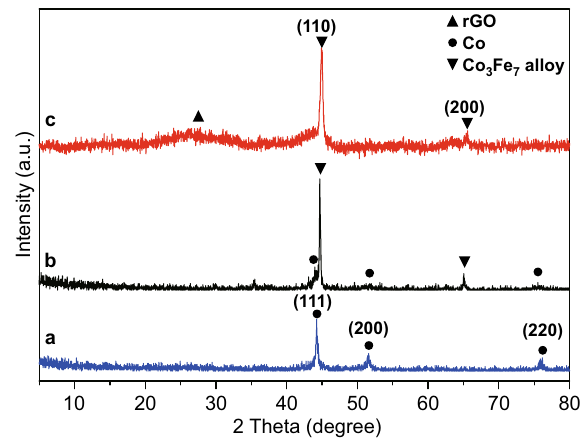
Fig. 3 XRD patterns of a Co/NC, b Fe–Co/NC, and c Fe–Co/NC/ rGO